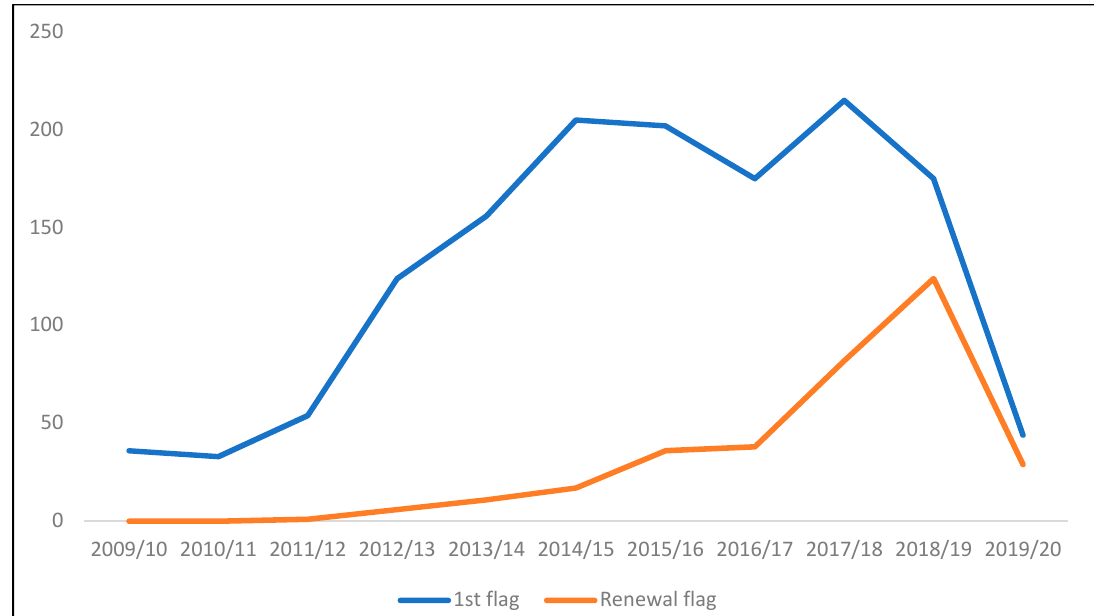
Figure 2. Number of schools receiving their first flag and number of schools renewing their flag each academic year. Note: Covid-19-related school closures from March to June 2020 likely impacted applications and renewals for the ASF programme .